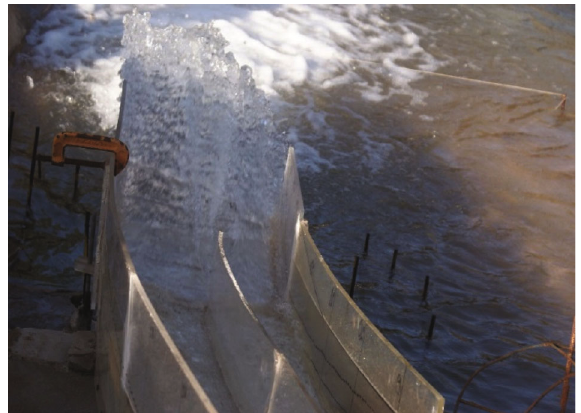
Figure 17: The fl ow in the chute after the addition of the dividing wall-physical